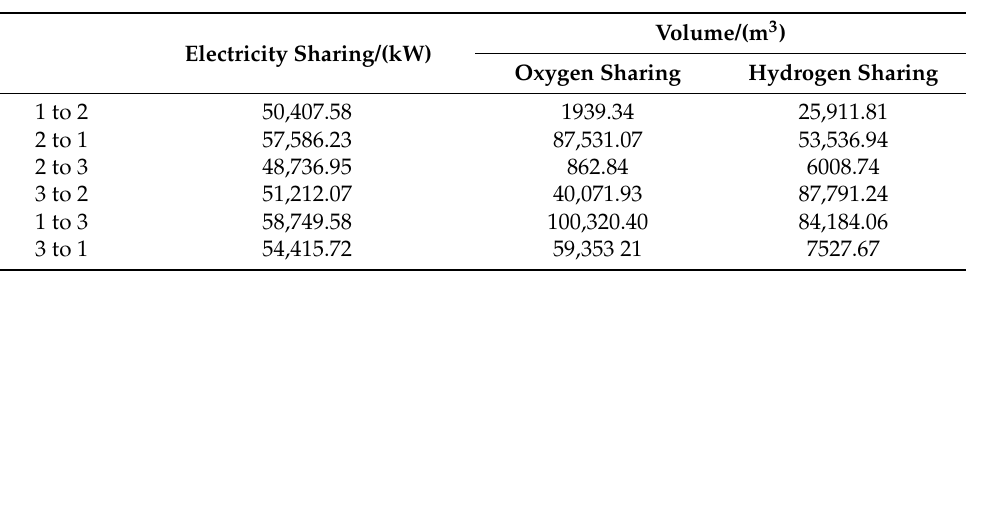
Table 10. Multi-energy